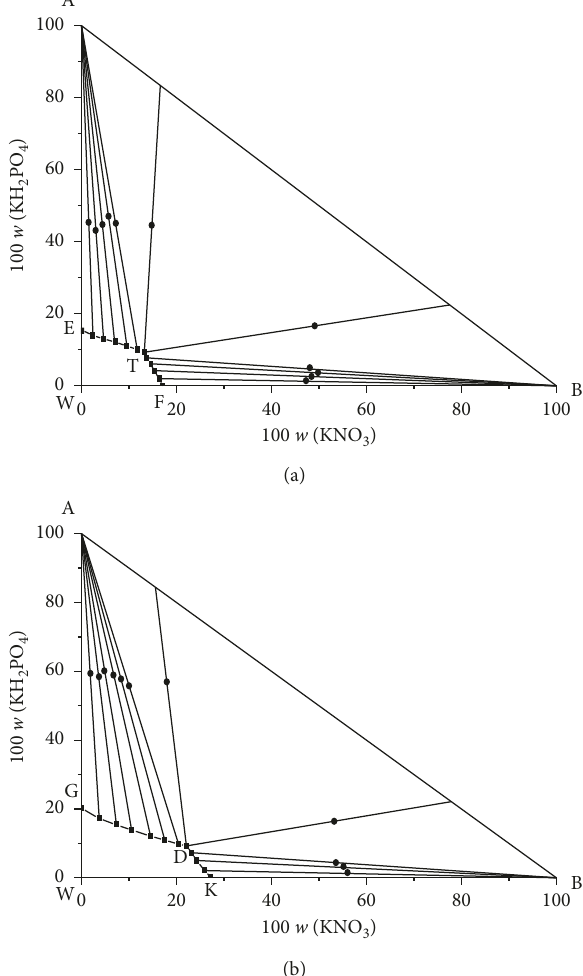
Figure 3: Equilibrium phase diagram of the ternary system KH 2 PO 4 +KNO 3 +H 2 O at (a) 283.15 and (b) 298.15K. equilib- rium liquid phase composition; moist solid phase composition; A, pure solid of KH 2 PO 4 ; B, pure solid of KNO 3 ; W, water; E and G, solubility of KH 2 PO 4 in water; F and K, solubility of KNO 3 in water; T and D, cosaturated point of KNO 3 and KH 2 PO 4